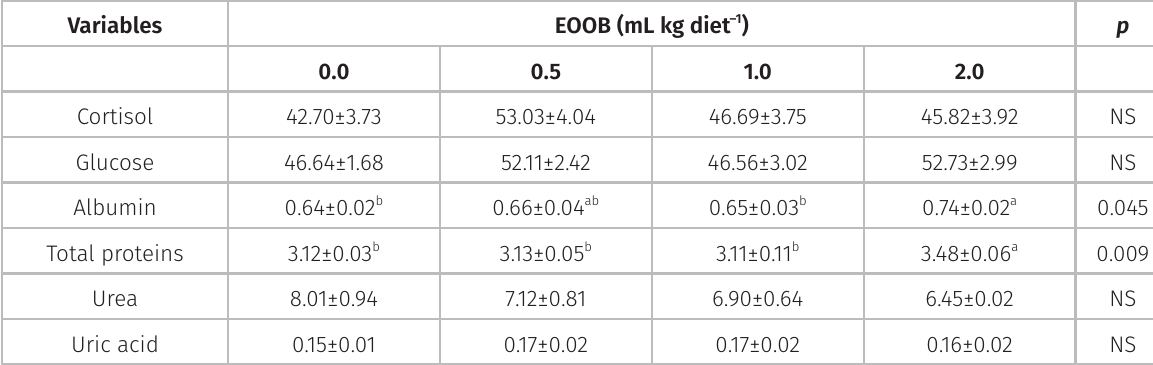
Table III. Plasma biochemical variables (mean ± SEM) of pirarucu fed with diets containing different concentrations of the essential oil of Ocimum basilicum